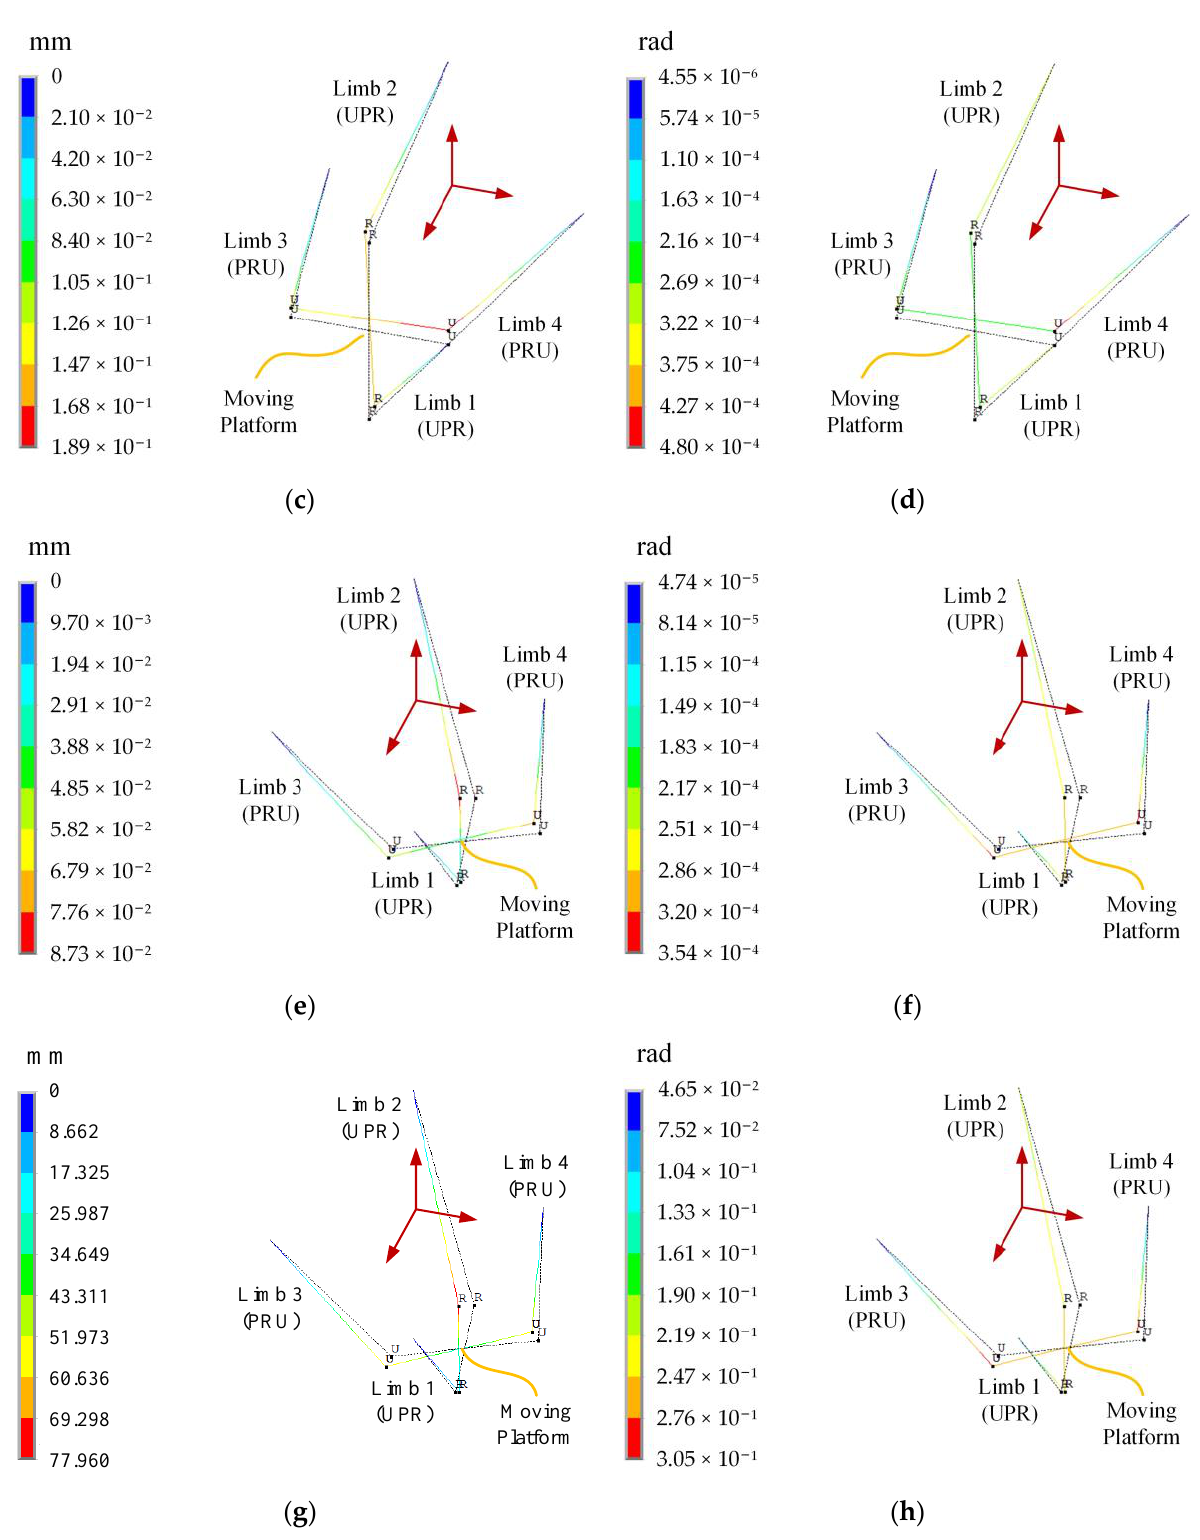
Figure 7. Linear and angular deformations of the redundantly actuated 2UPR – 2PRU PM in four selected cases: ( a ) linear deformation of case 1; ( b ) angular deformation of case 1; ( c ) linear deformation of case 2; ( d ) angular deformation of case 2; ( e ) linear deformation of case 3; ( f ) angular deformation of case 3; ( g ) linear deformation of case 4; ( h ) angular deformation of case 4. Table 3. Comparison results between the FEA method and theoretical method for the deformation in the four selected cases.